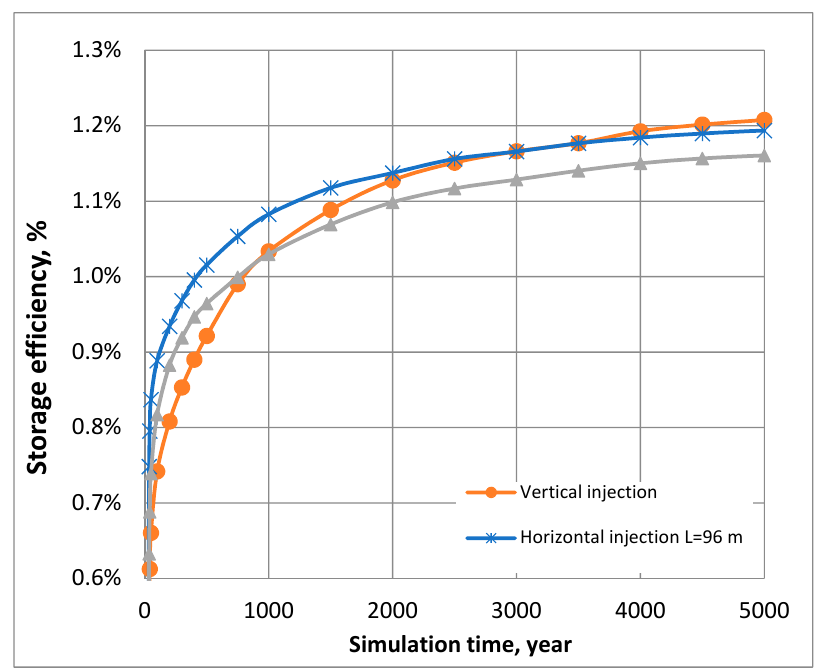
Figure 15. CO 2 storage efficiency for different injection orientation scenarios—cases 10, 11 and 12 in Table